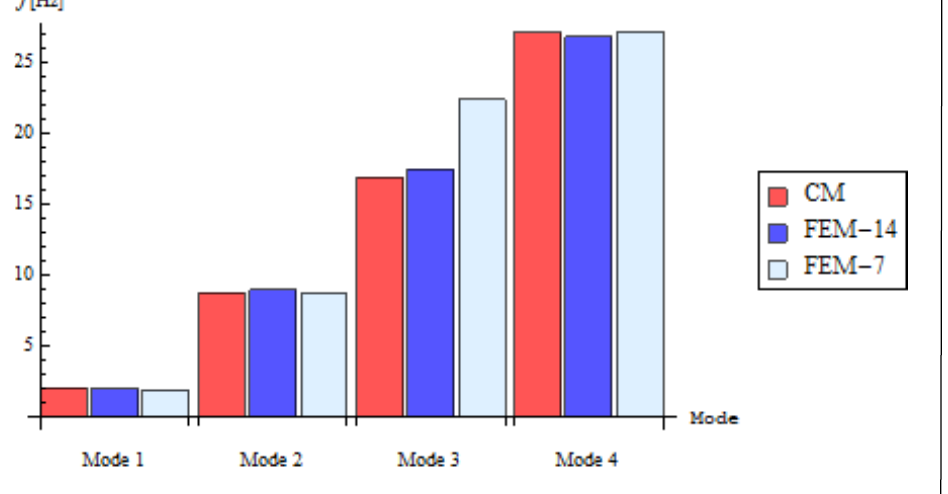
Figure 11 – Influence of the number of finite elements on the accuracy results Рис. 11 – Влияние количества конечных элементов на точность результатов Слика 11 – Утицај броја коначних елемената на тачност